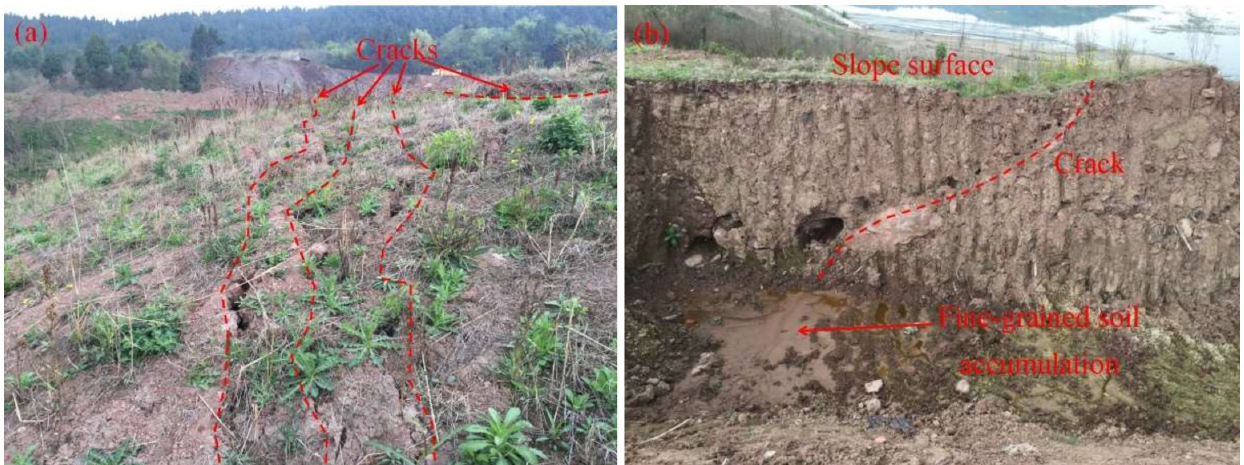
Figure 15. Characteristics of crack development before slope failure: ( a ) characteristics of slope surface cracks; ( b ) characteristics of section